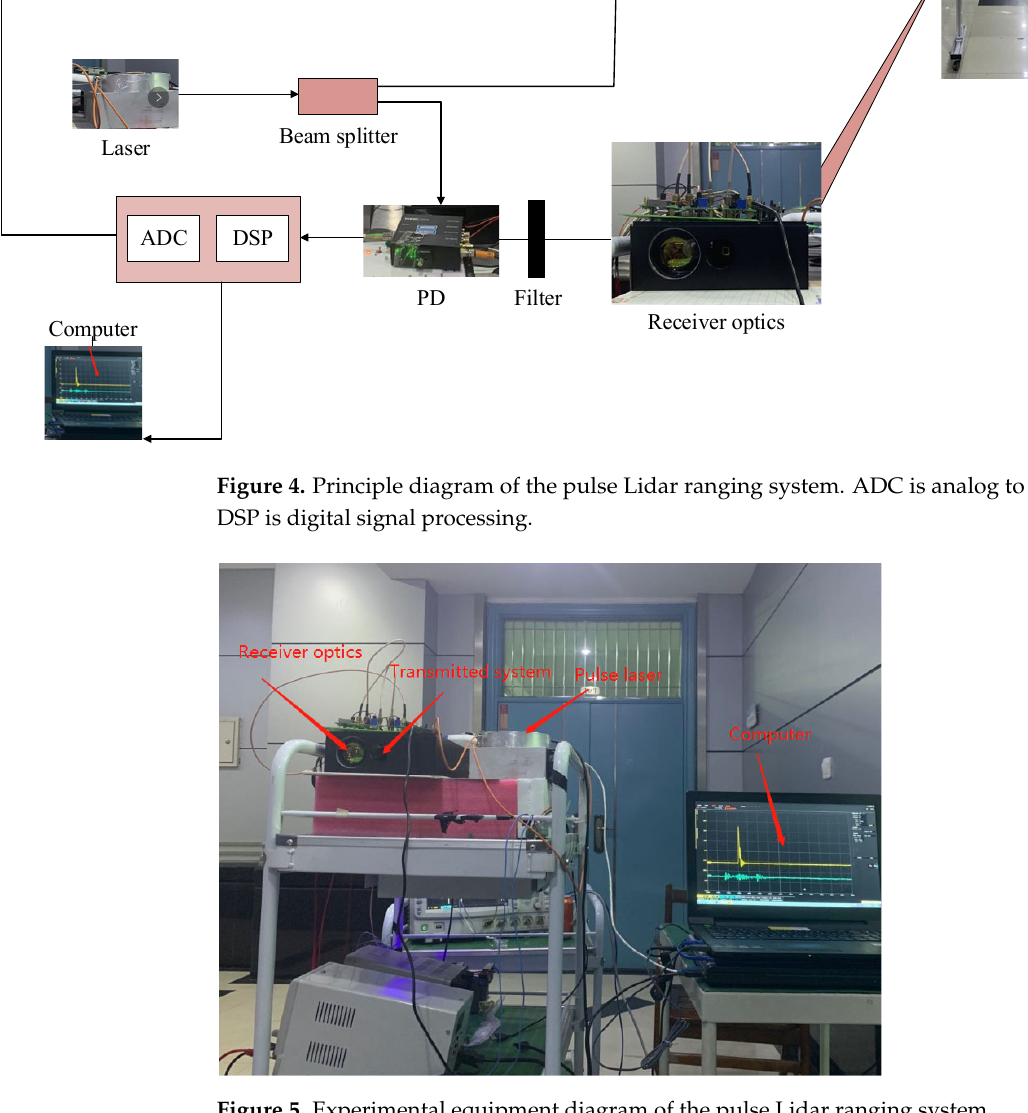
Figure 4. Principle diagram of the pulse Lidar ranging system. ADC is analog to digital converter, DSP is digital signal processing. Table 2. Specifications of the Lidar system.